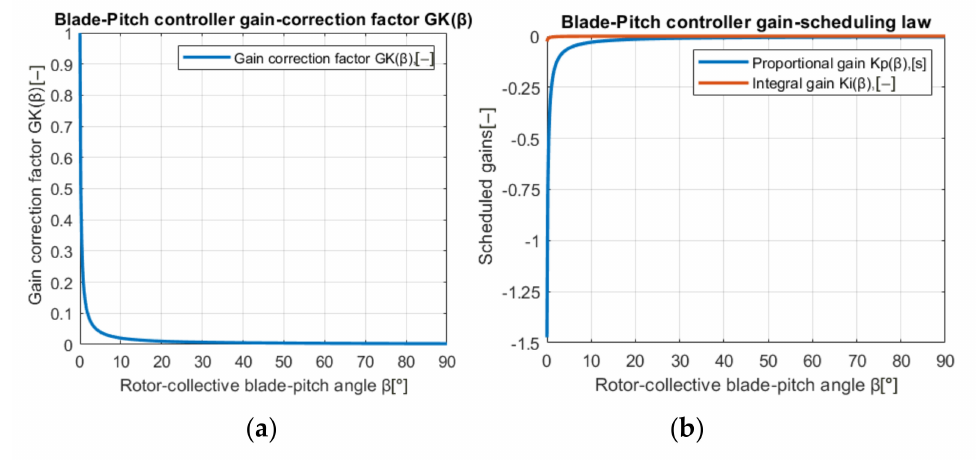
Figure 5. WT blade-pitch controller ( a ) gain correction factor GK( β ); ( b ) gain scheduling law. By combining a blade-pitching angle PI closed-loop equation with the linear